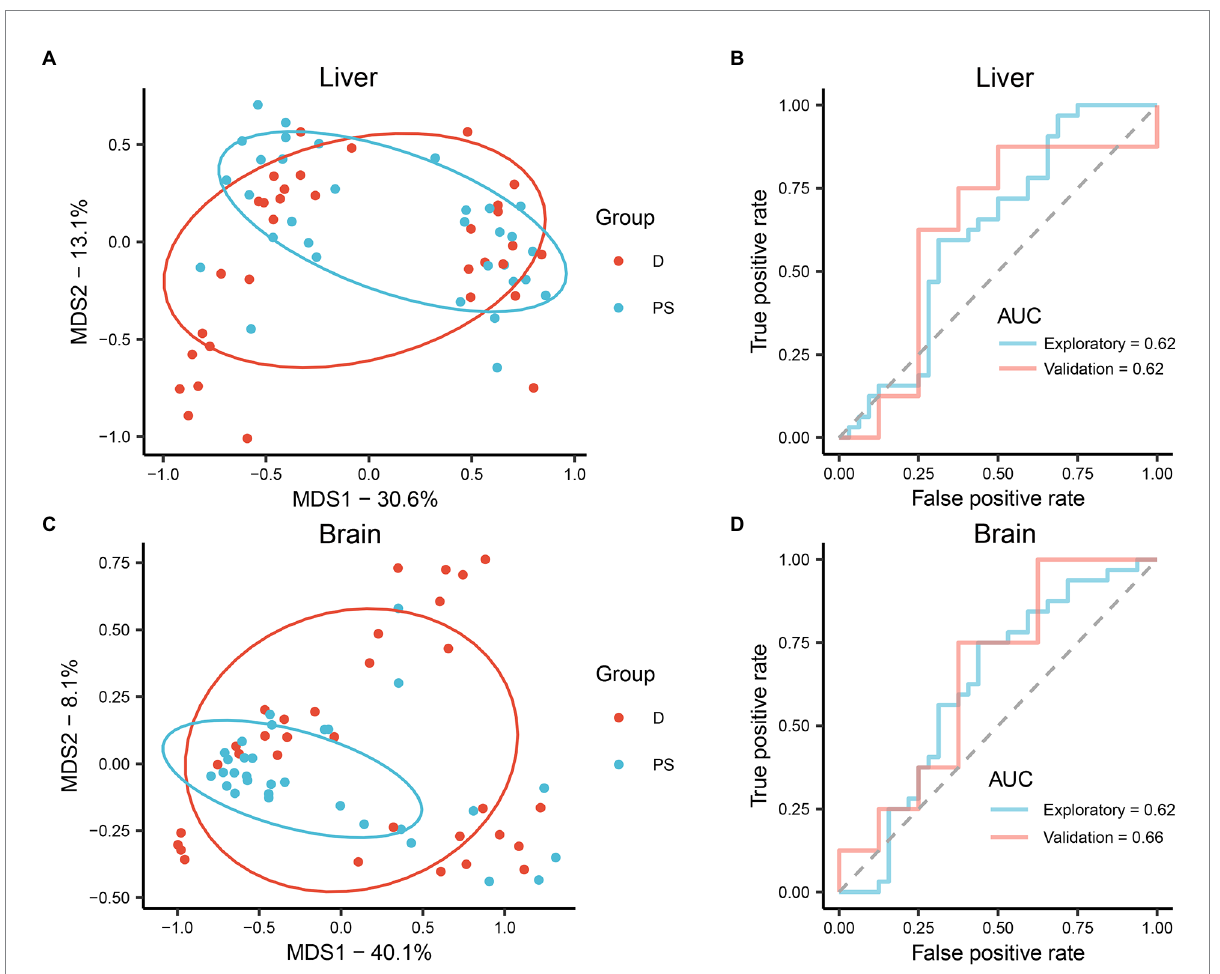
FIGURE 3 (A,B) Performance of the RF classification model built on microbiota in the liver. (C,D) Performance of the RF classification model built on microbiota in the brain. (A,C) MDS plot generated by the learning algorithm RF comparing the microbial community between drowning and postmortem submersion groups. (B,D) ROC curves of the RF classification model on data from exploratory and validation experiments. D, drowning group; PS, postmortem submersion